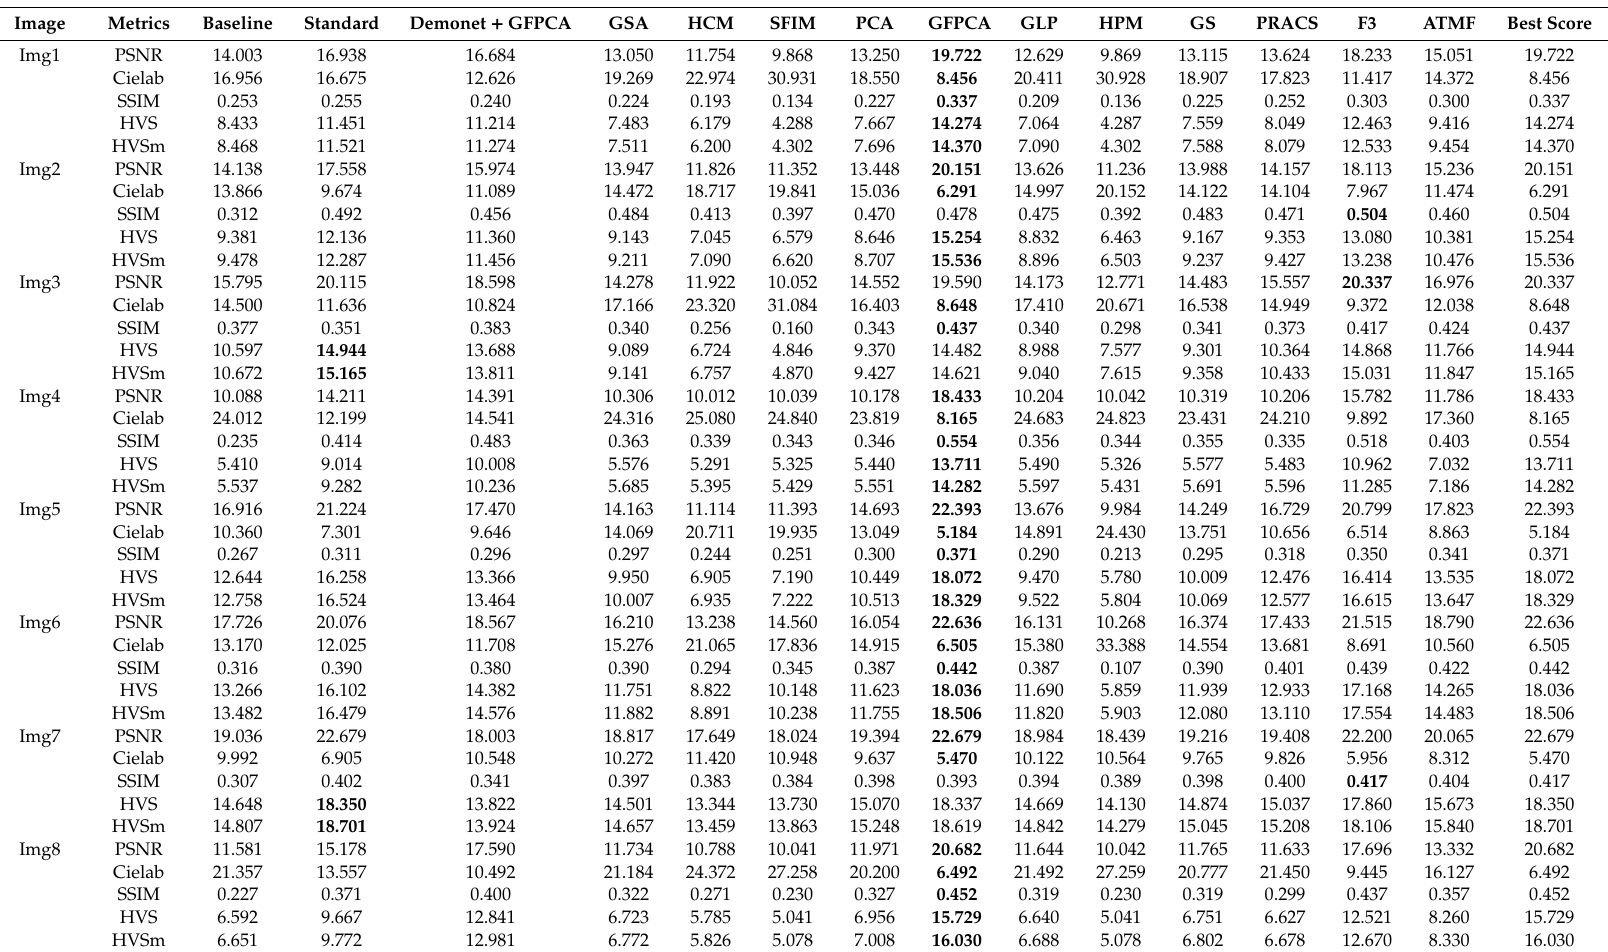
Table A3. Performance metrics of 14 algorithms at 10 dBs SNR. Bold numbers indicate the best performing methods in each row. Red numbers indicate those methods used in F3 and those red and green numbers indicate those methods used in